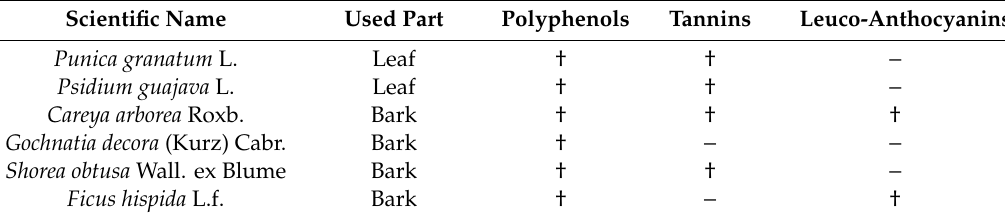
Table 1. Phytochemical screening test.